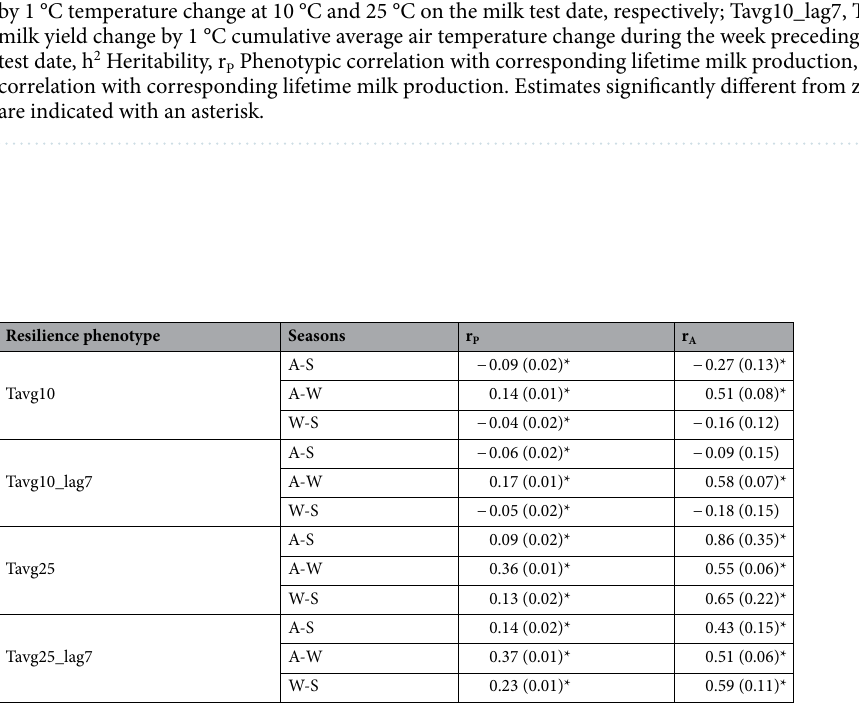
Table 4. Correlation estimates between different seasonal animal resilience phenotypes (standard errors in parentheses). Tavg10, Tavg25: milk yield change by 1 °C temperature change at 10 °C and 25 °C on the milk test date, respectively; Tavg10_lag7, Tavg25_lag7: milk yield change by 1 °C cumulative average air temperature change during the week preceding the milk test date, A-S autumn-spring, A-W autumn–winter, W-S winter- spring, r P Phenotypic correlation between different seasonal resilience phenotypes, r A Genetic correlation between different seasonal resilience phenotypes. Estimates significantly different from zero (P < 0.01) are indicated with an